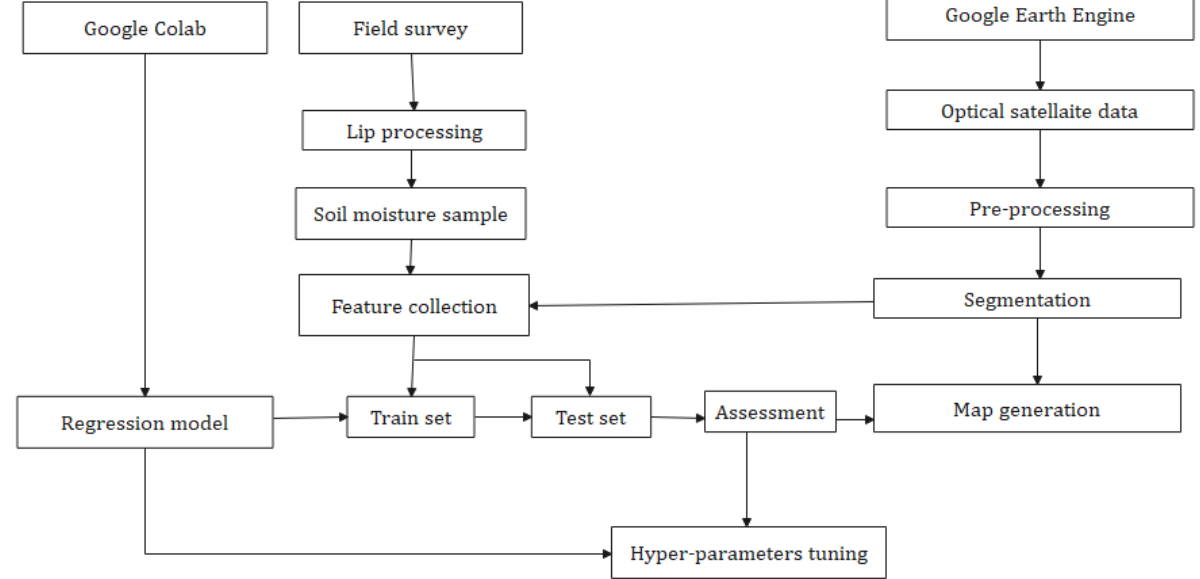
Figure 2. Flowchart illustrating the steps for SMC prediction using satellite data.